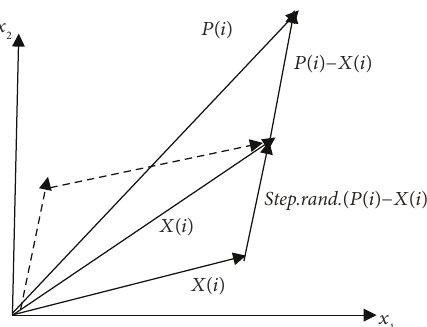
Figure 12: The 2-D path of a cockroach consisting of the X ( i ) chase P ( i ) yielding the new position X ( i